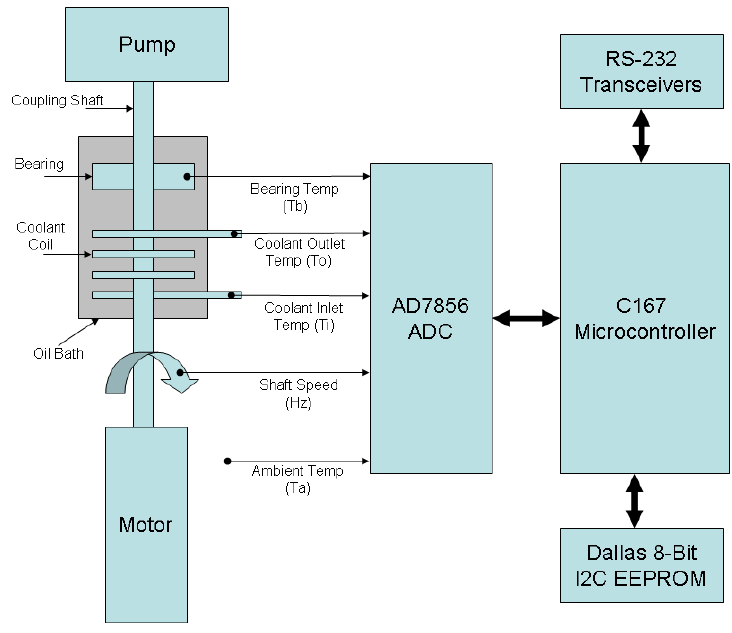
Figure 4. Main hardware elements employed in the system.